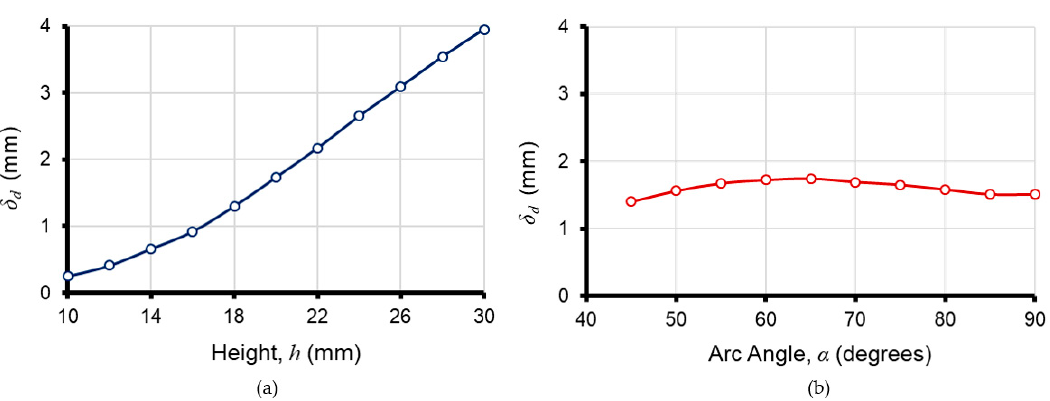
Figure 5. Displacement ( δ d ) as a function of both ( a ) actuator height ( h ) and ( b ) arc angle ( α ) for t d = 2 mm and P a = 6.89 kPa ( 1 psi ) .